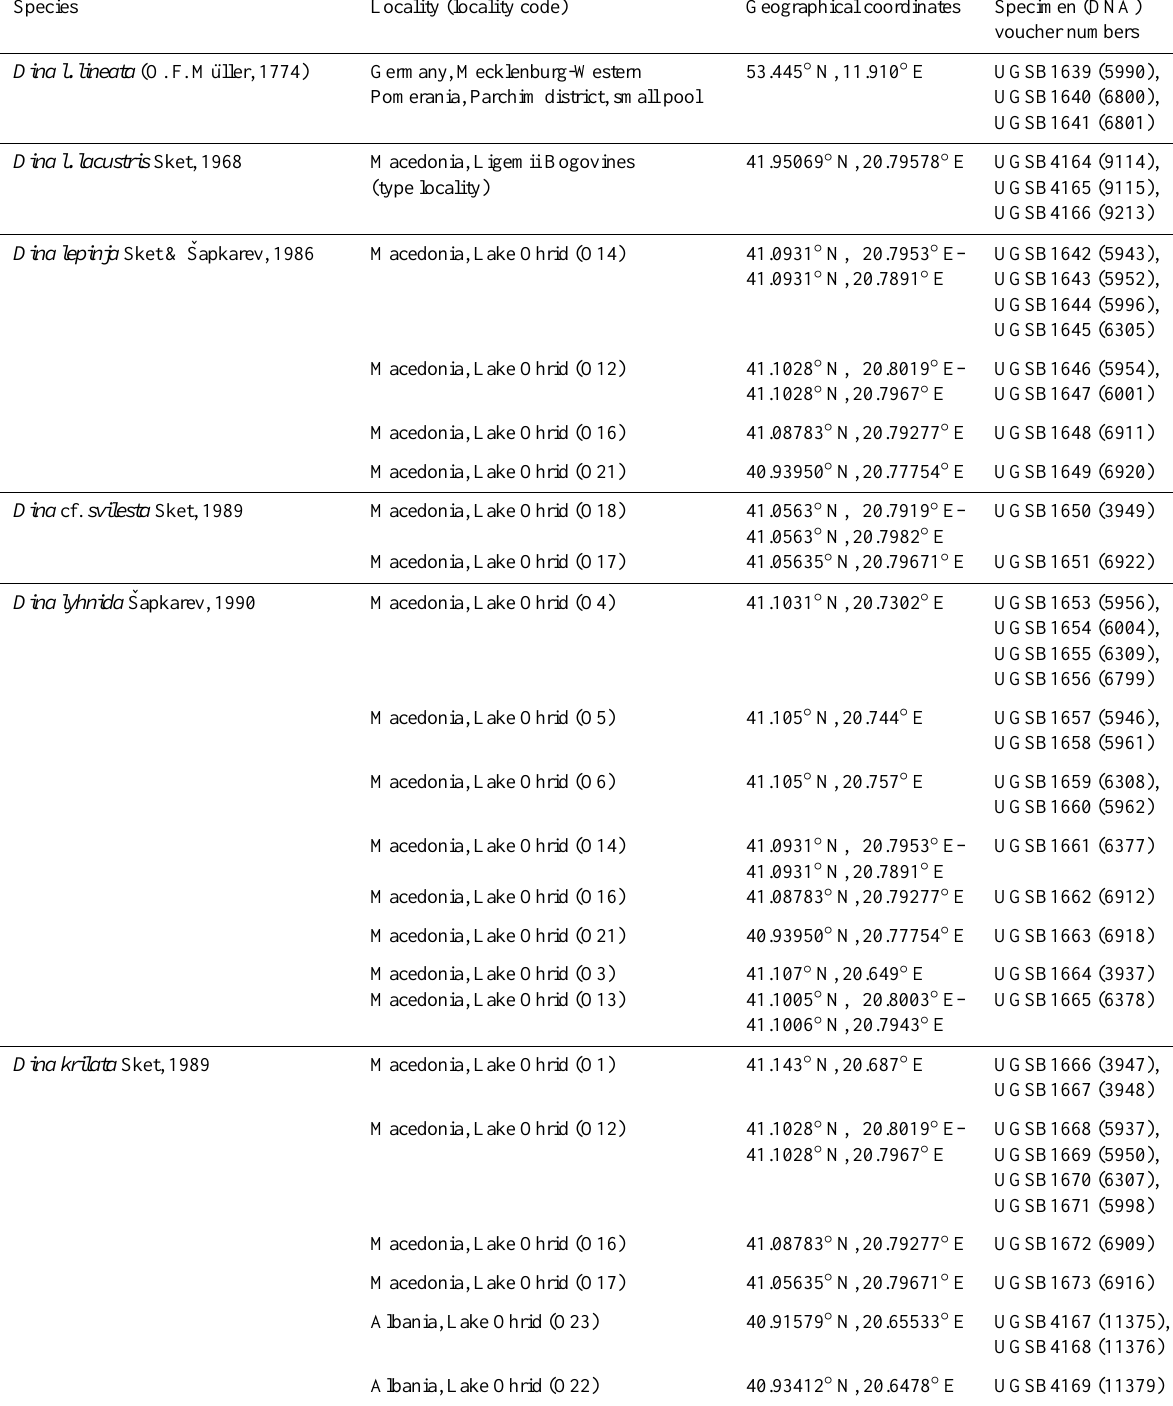
Table 1. Information on specimens of Hirudinea studied, including locality information for collecting points and transects, locality codes according to Fig. 2, and voucher numbers for specimens and DNA preps deposited at the University of Giessen Systematics and Biodiversity Collection (UGSB). Nomenclature follows Nesemann and Neubert (1999). See text for GenBank accession numbers and information on sequences obtained from